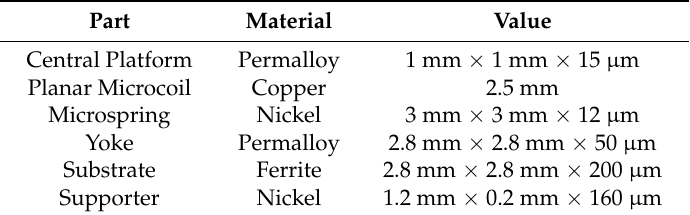
Figure 1. The structure and working mechanism of the microactuator. ( a ) Structure; ( b ) Open state; ( c ) Closed state. Table 1. Properties of the microactuator.